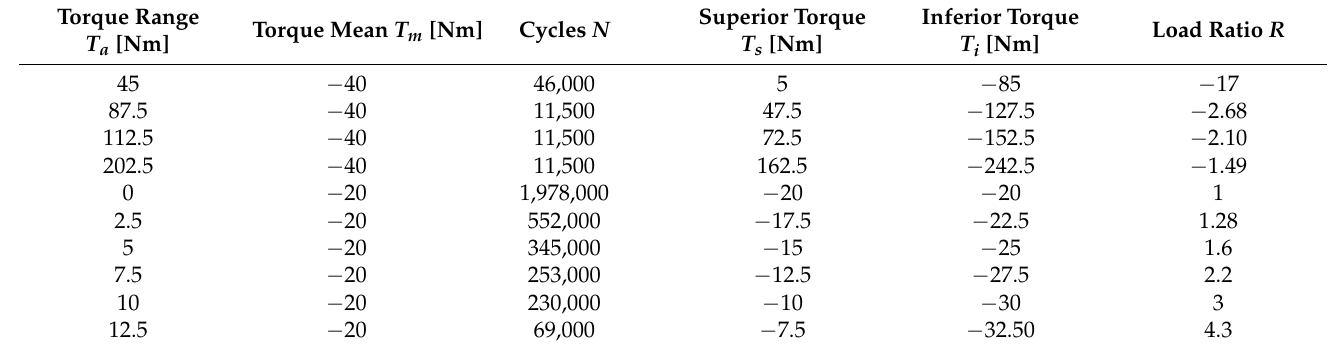
Table 6. First ten load histories from Rainflow method counting (HEV model).